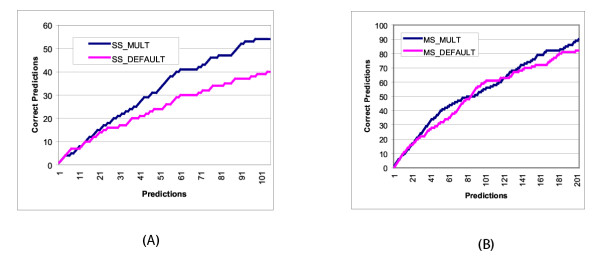
Prediction accuracy under the requirement that each predicted gene be evidenced by at least two predicted CRM's. "MULT" refers to this strategy, while "DEFAULT" refers to the default mapping of CRM's, without this restriction. (a) STUBBSS (b) STUBBMS.